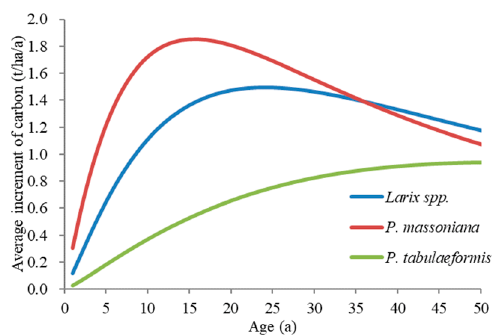
Figure 7. Average increment of carbon storage curves for the three plantation types.